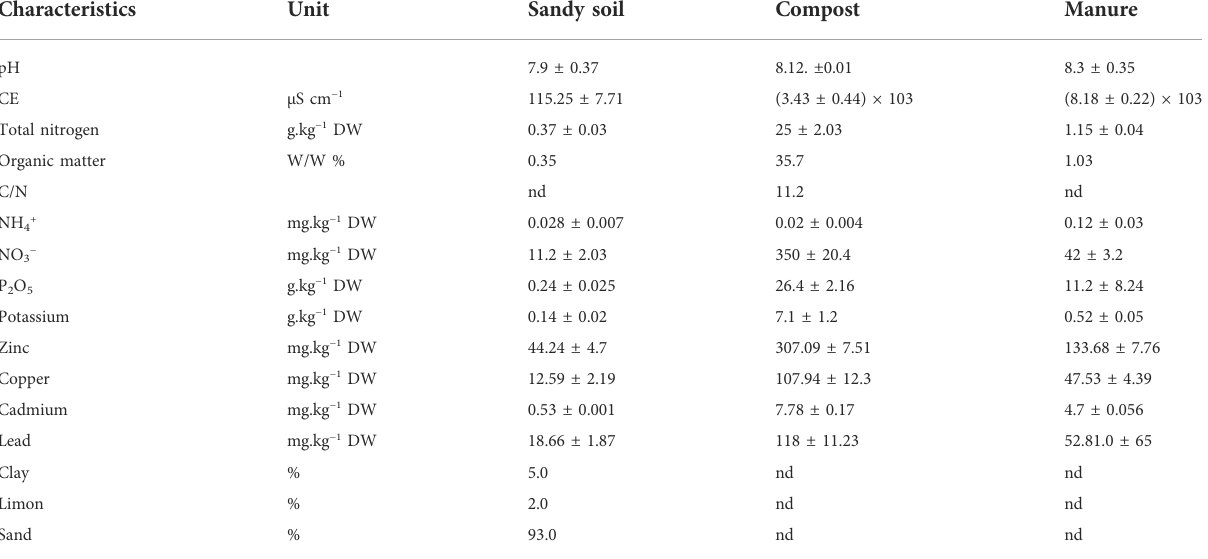
TABLE1Thecharacteristicsofclaysoil,farmyardmanure(M),andmunicipalsolidwastecompost(CO).Dataaremeansofthreerepeats±SE.nd=not